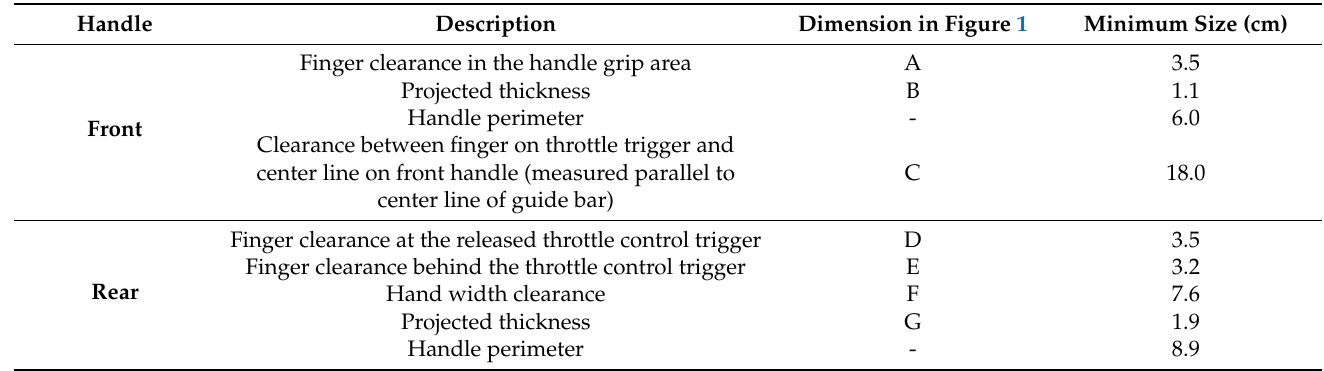
Table 1. Minimum chainsaw handle clearances and sizes adapted from [23] with permission from International Labour Office, 1978, and Figure